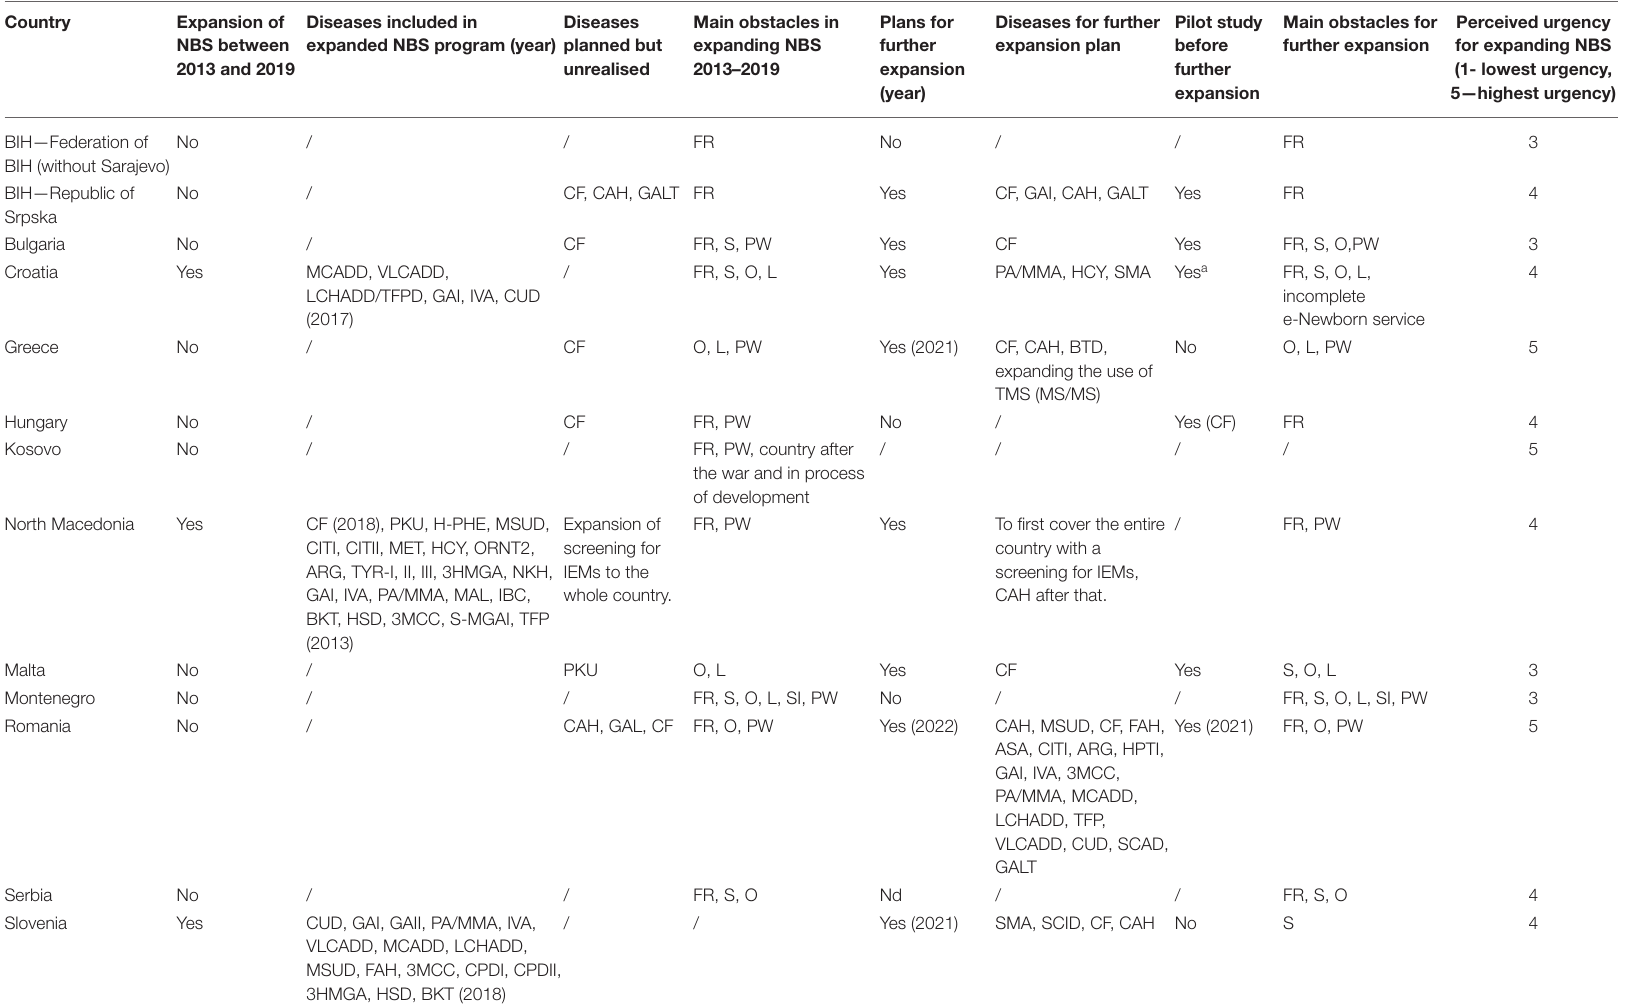
TABLE 2 | Past developments and future plans in newborn screening programs in southeastern